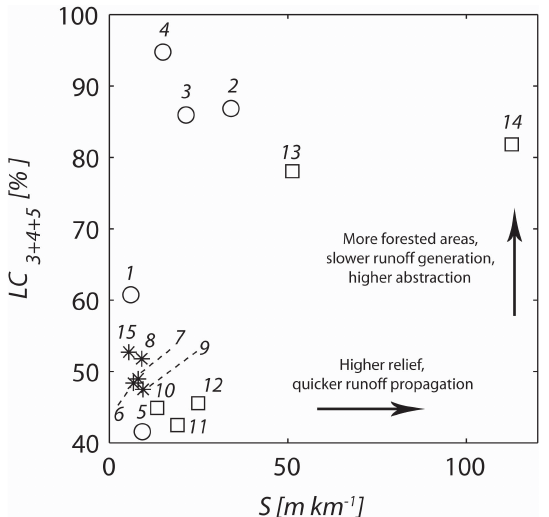
Fig. 6. Scatterplot of LC 3 + 4 + 5 vs. S (see Table 1). Sub-basins of group (a) are indicated with circles, those of group (b) with squares and the remaining sub-catchments with